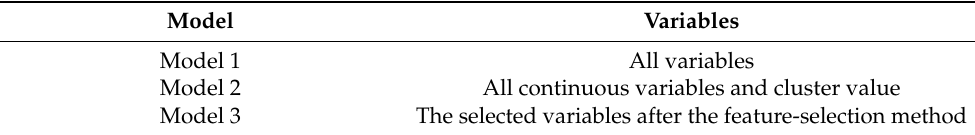
Table 1. Summary of the developed